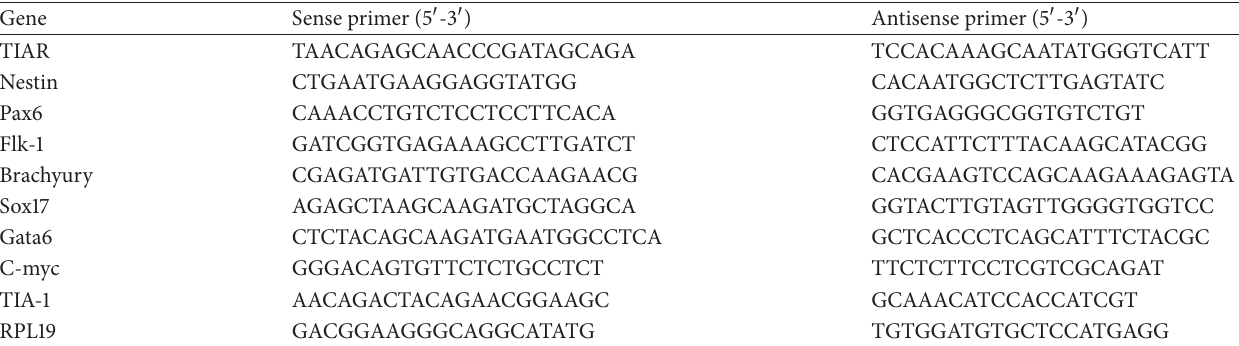
Table 4: Primers used for quantitative reverse-transcription polymerase chain